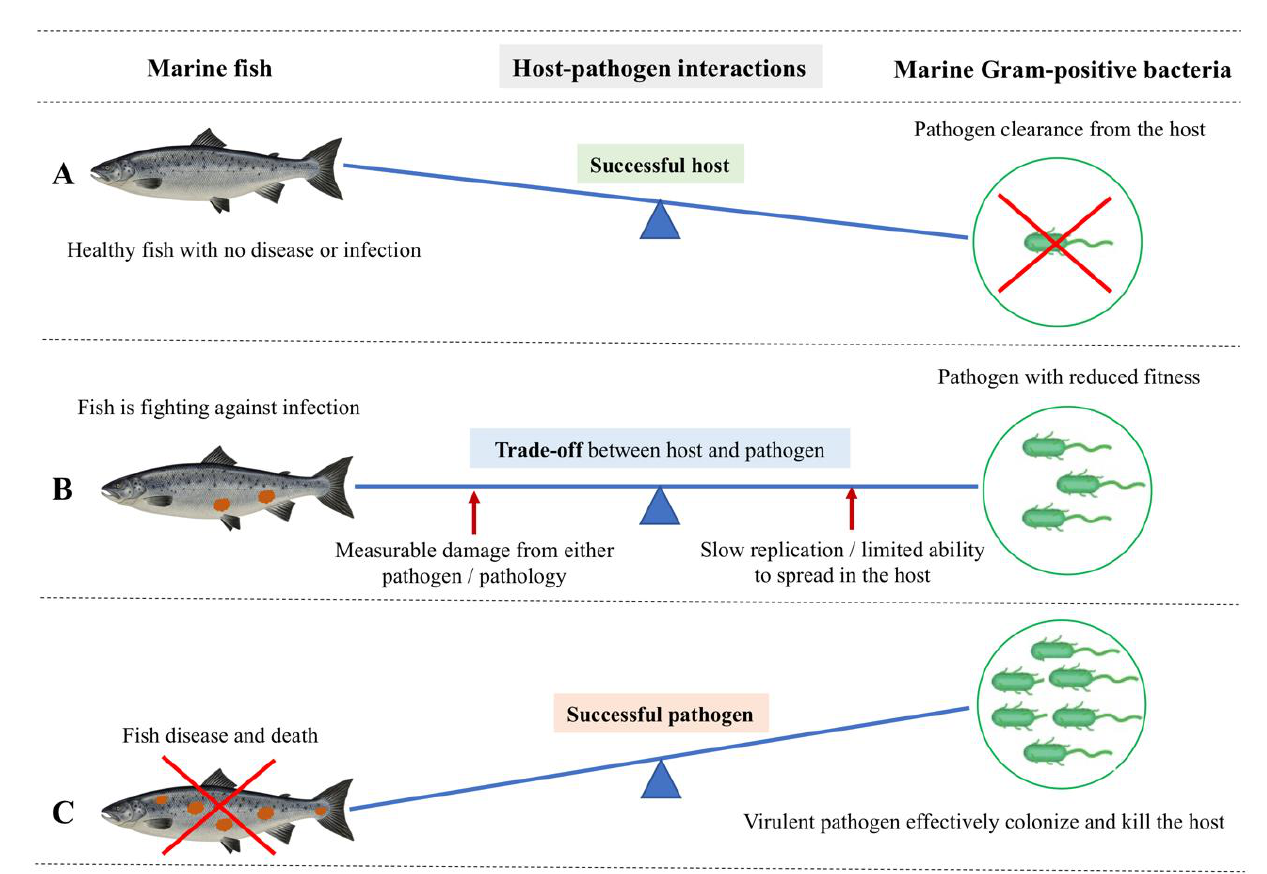
Figure 1. Schematic representations of ( A ) how virulence is modulated in a dynamic host – pathogen interaction [21] (the yellow shaded area expresses virulence as an outcome of a dynamic host-pathogen interaction in a conducive marine environment) and ( B ) how the disease process occurs as a result of complex host-pathogen-environment interactions. This figure was generated by the authors using BioRender (https://biorender.com/) (accessed on 1 August 2022).